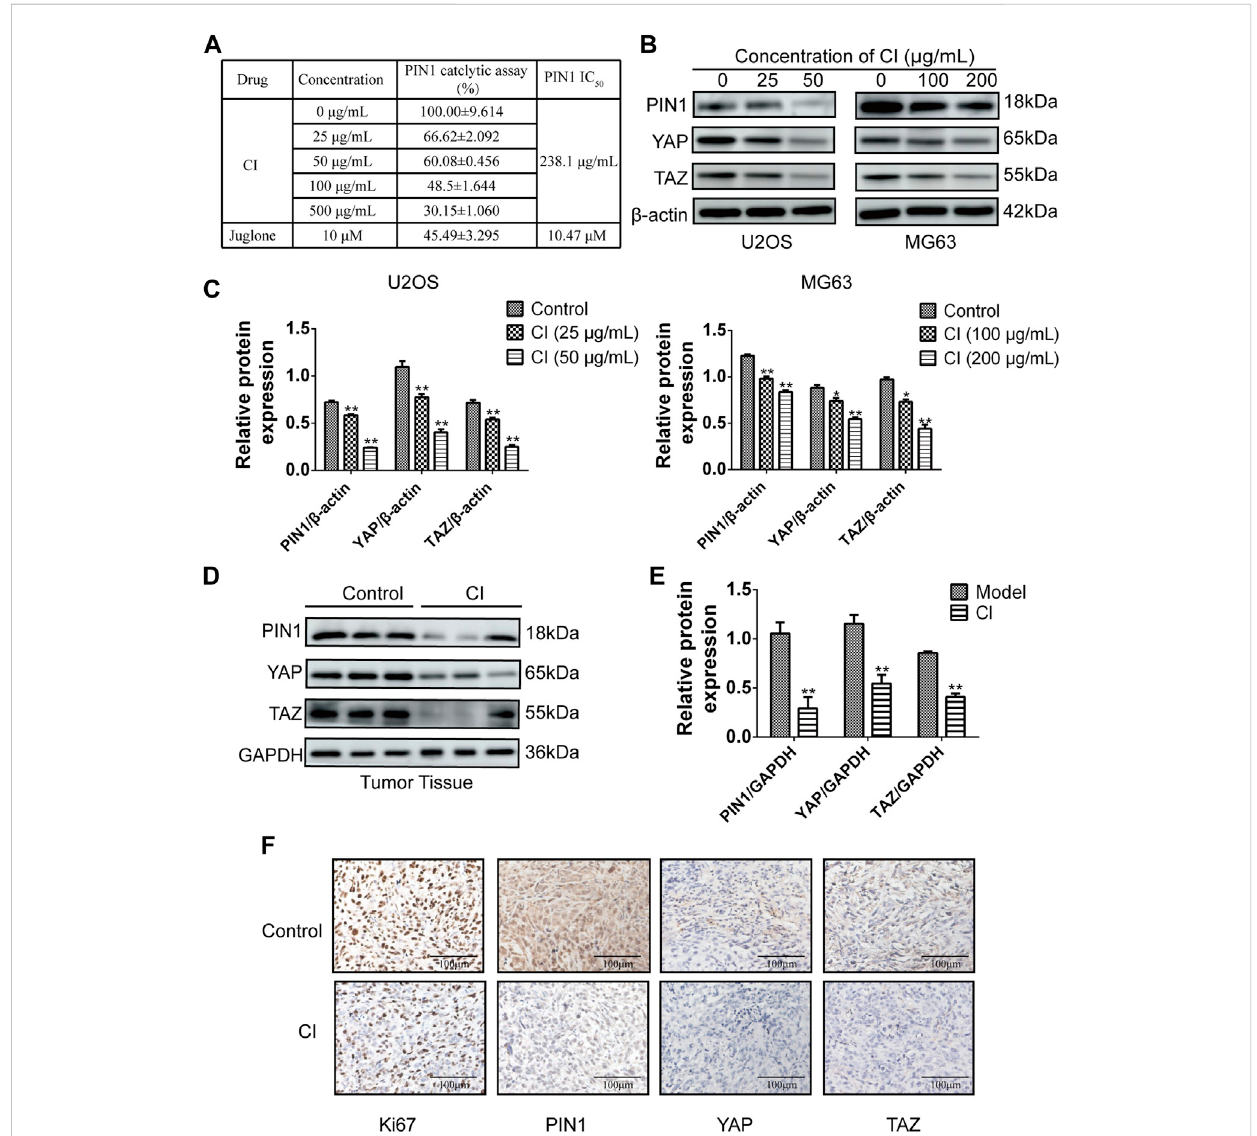
CI inhibits the PIN1-YAP/TAZ pathway in vivo and vitro . (A) PPIase isomerase inhibition assay of PIN1 with CI. Results were presented as the mean ± SEM of three independent experiments. (B) The expression levels of PIN1, YAP and TAZ were detected by western bolt after CI treatment in U2OS and MG63 cells. (C) Quanti fi cation of western blot data from (B) . Results were presented as the mean ± SEM of three independent experiments. * p < 0.05, ** p < 0.01 vs . control group (one-way ANOVA). (D) The expression levels of PIN1, YAP and TAZ were detected by western bolt after CI in ectopic subcutaneous tumor model of U2OS. (E) Quanti fi cation of western blot data from (D) . Results were presented as the mean ± SEM of three independent experiments. * p < 0.05, ** p < 0.01 vs . model group ( t -test). (F) Immunohistochemical analysis of paraf fi n-embedded U2OS mice tumor tissue sections using antibody (Ki67, PIN1, YAP, TAZ). Scale bar stands for 100 μ